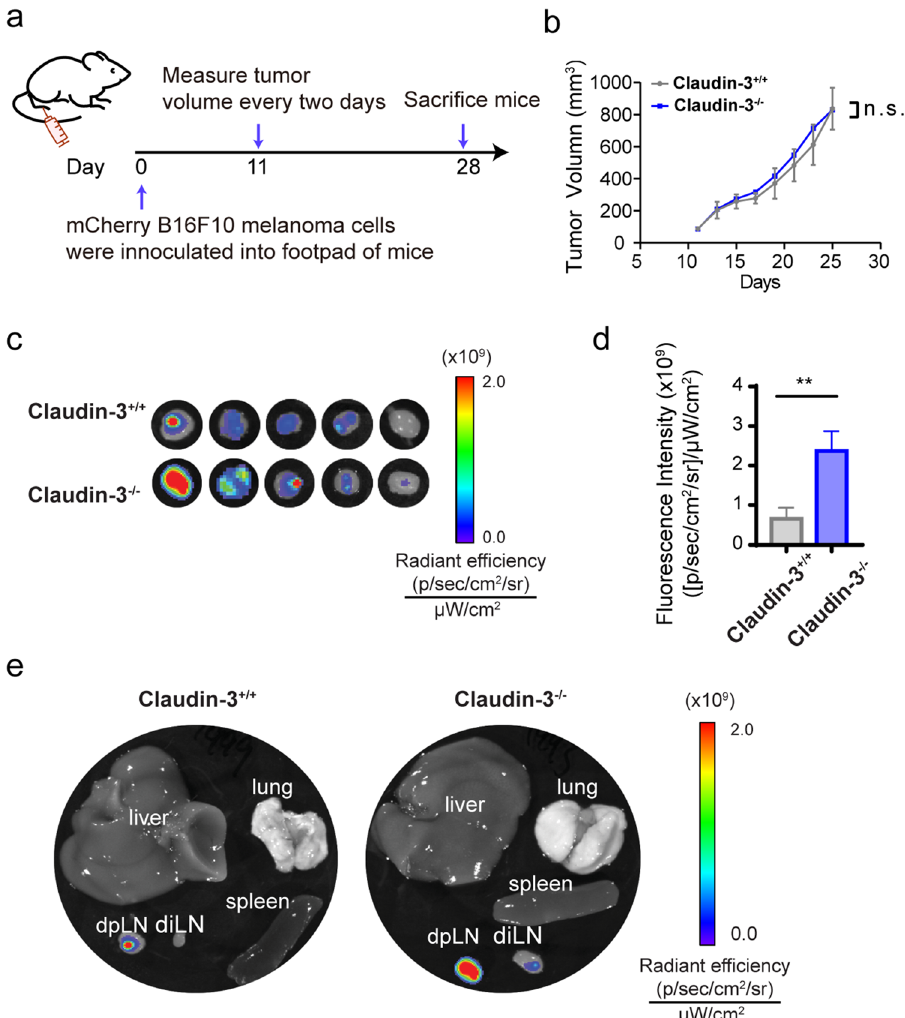
Figure 1. Loss of claudin-3 augmented B16F10 melanoma lymphatic metastasis. ( a ) Schematic flowchart shows the establishment of B16F10 melanoma transplantation model in mice. ( b ) The tumor volume was measured and calculated after day 9 as described in the method part. (ns: no significance) (n = 5 mice per group) ( c ) mCherry fluorescence was detected by IVIS in ipsilateral popliteal lymph nodes (dpLN) of the footpad injection site from claudin-3 −/− and claudin-3 +/+ mice. (n = 5 mice per group) ( d ) Quantification of metastasized mCherry labeled B16F10 cells in dpLN was measured by IVIS. Statistical analysis of fluorescence was conducted. Values are shown as the mean ± SEM. (** p < 0.01) (n = 5 mice per group) ( e ) After sacrificing the mice, ipsilateral popliteal lymph node (dpLN), ipsilateral inguinal lymph node (diLN), liver, lung, and spleen were collected. Representative images show the fluorescence examined by